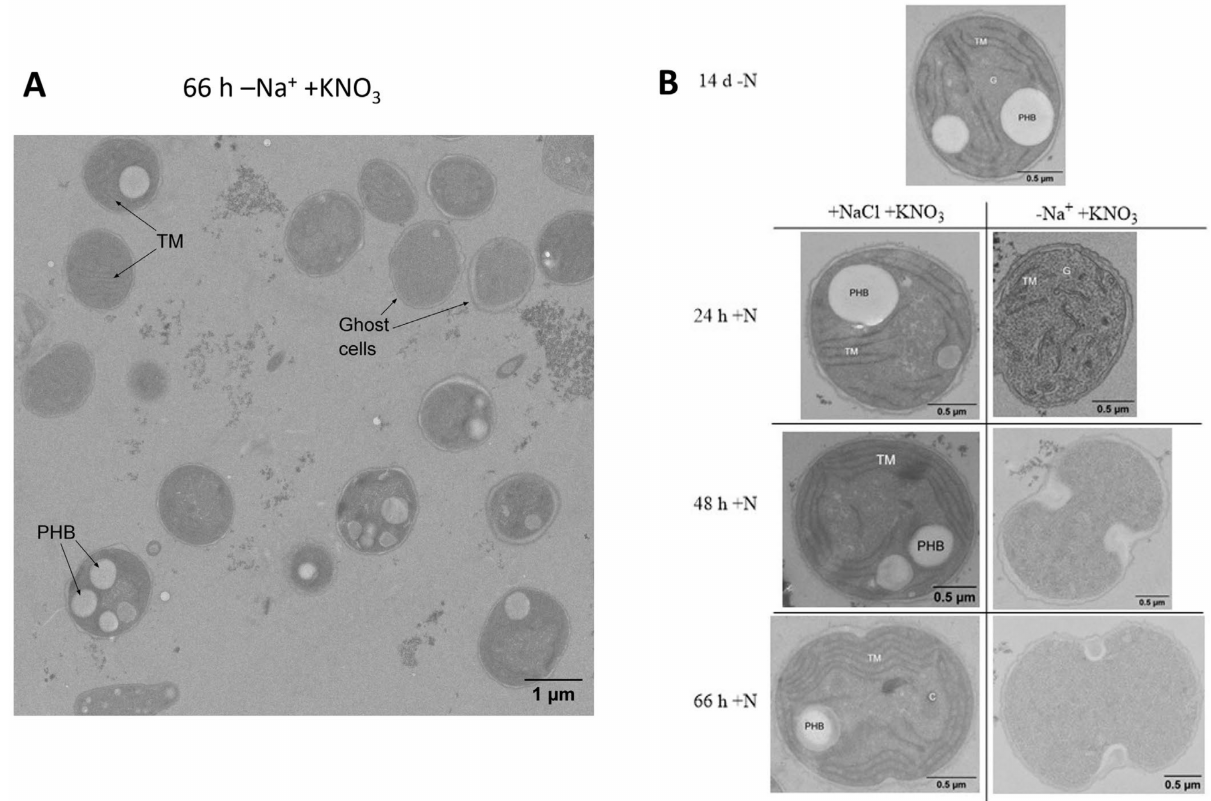
Figure 5. TEM pictures of resuscitating cells in the presence and absence of sodium. ( A ) provides an overview of multiple cells 66 h after the start of resuscitation in the absence of sodium. ( B ) depicts individual cells in resuscitation. On the left side are cells recovering in the presence of sodium, on the right in the absence. Samples were taken before resuscitation (after 14 days of chlorosis) and 24, 48, and 66 h after initiation. TM = thylakoid membrane, PHB = polyhydroxybutyrate, G = glycogen, C = carboxysome. Scale bar in ( A ) represents 1 µ m, bars in ( B ) represent 0,5 µ